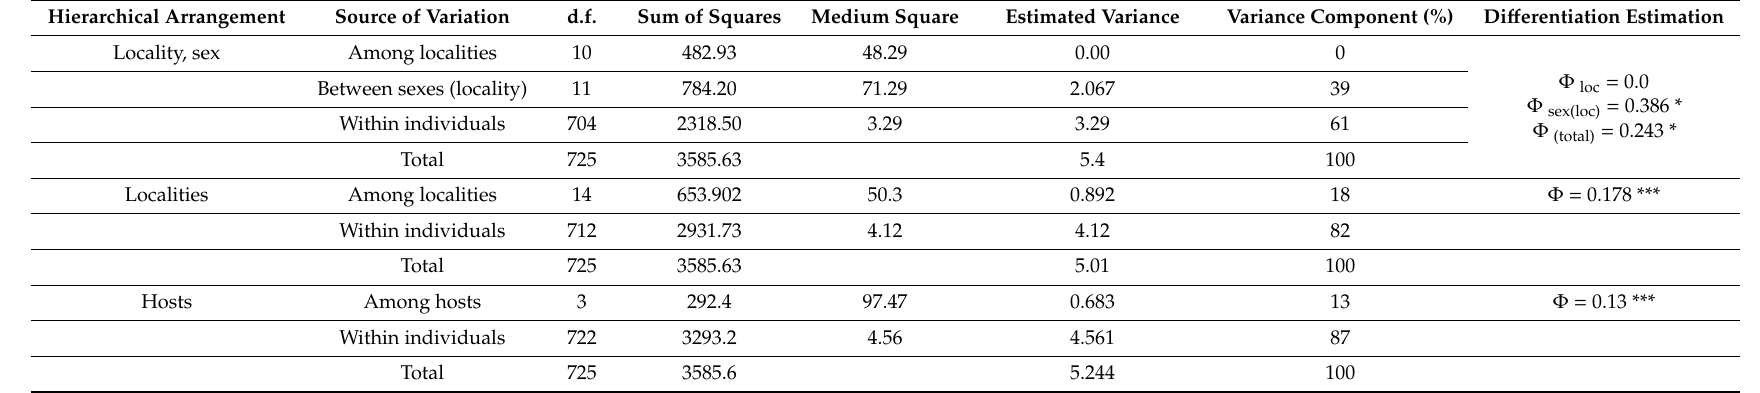
Table 6. Analysis of molecular variance for di ff erent hierarchical arrangements of samples of A. ludens obtained from 11 localities in the Soconusco region in Chiapas, Mexico. Φ loc , level of di ff erentiation among localities; Φ sex(loc), di ff erentiation between sex in relation to locality; Φ (total), di ff erentiation among all samples